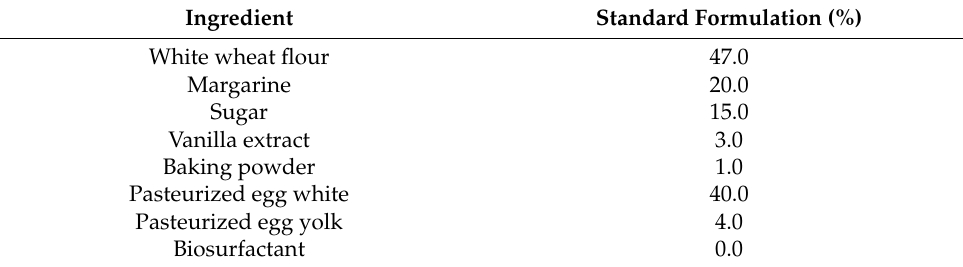
Table 1. Composition of the cookie